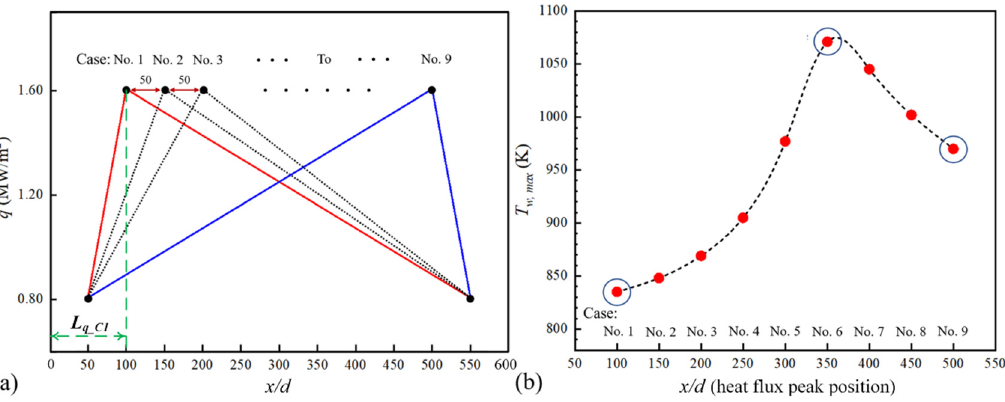
Figure 14. Axially nonuniform heat flux distributions ( a ) and heat flux peak positions ( b ) in different cases.